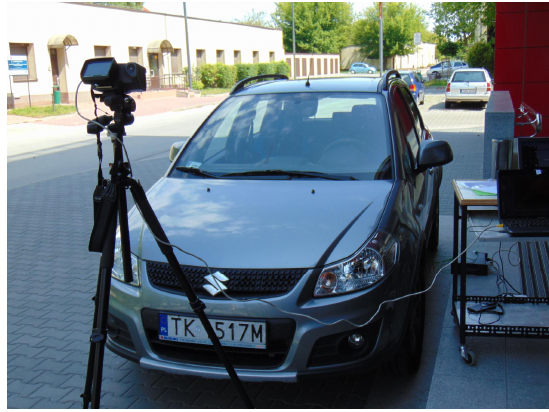
Fig. 1. Tested windscreen with a thermal camera.